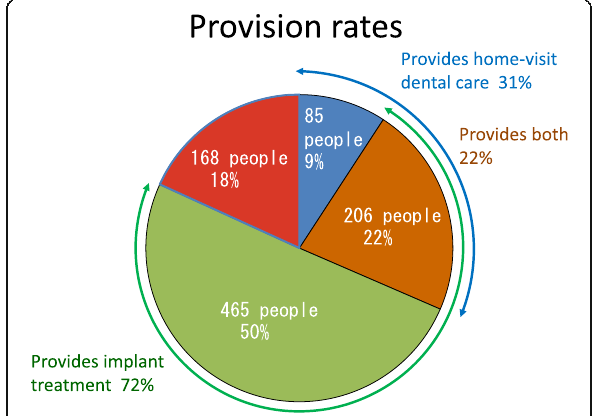
Fig. 2 Three implants were embedded in an artificial mandible